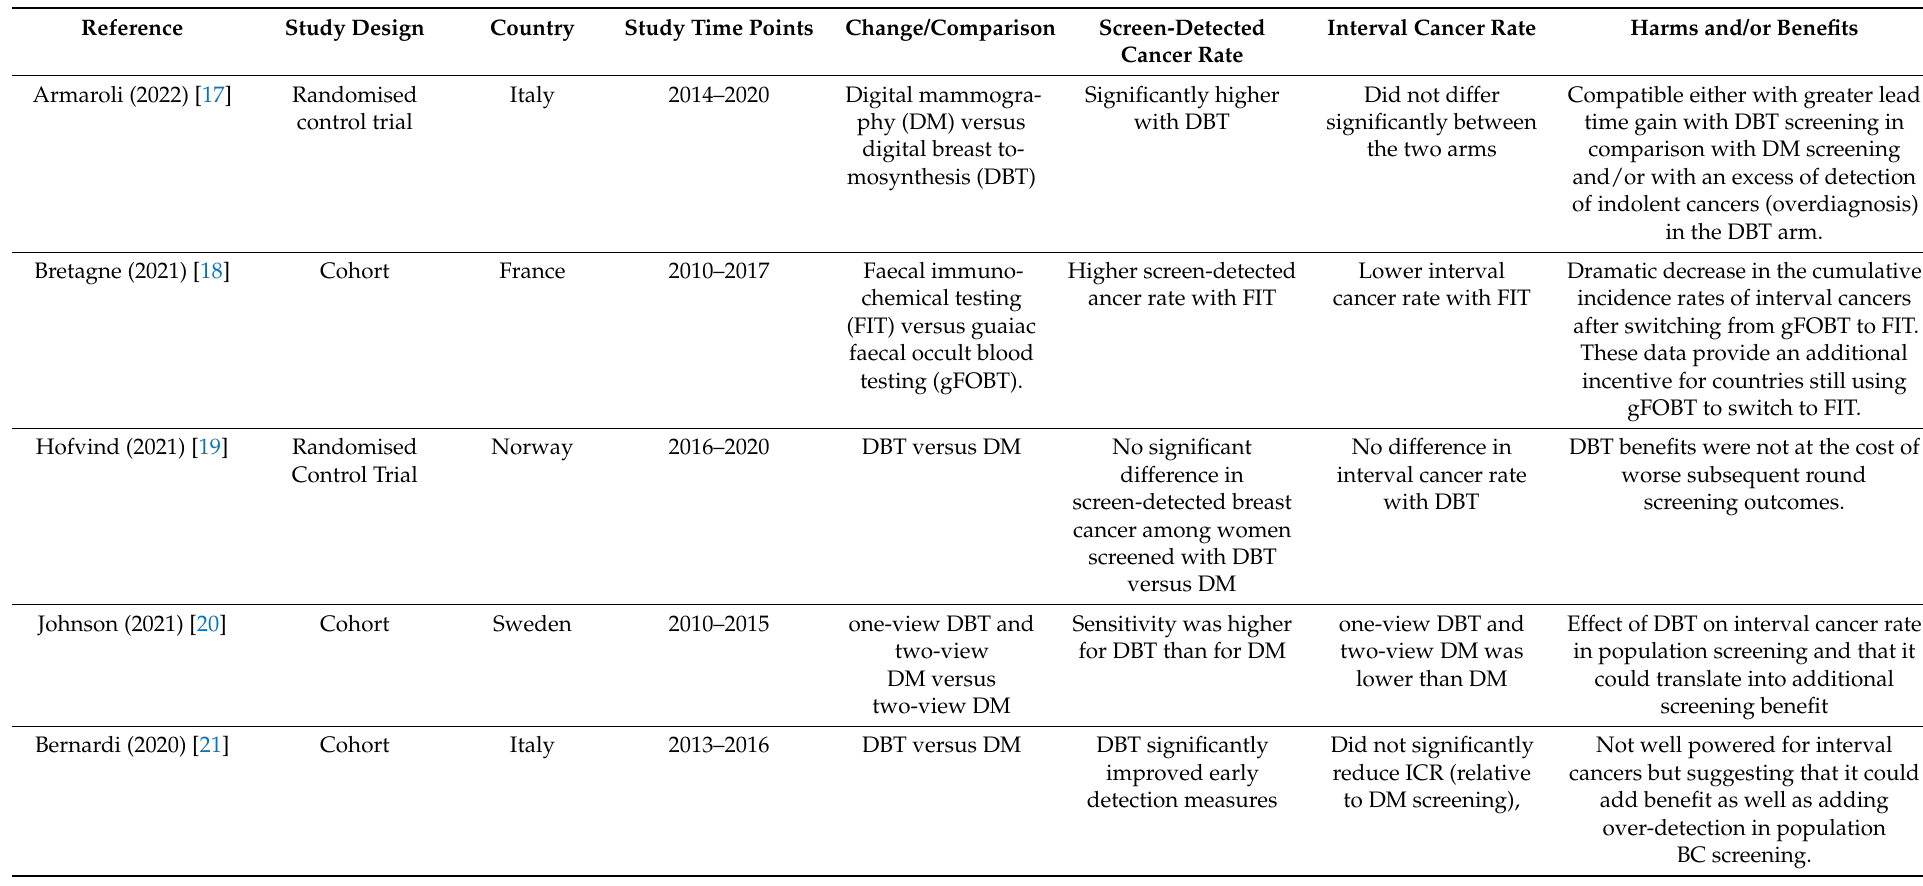
Table 1. Summary of selected studies from scoping